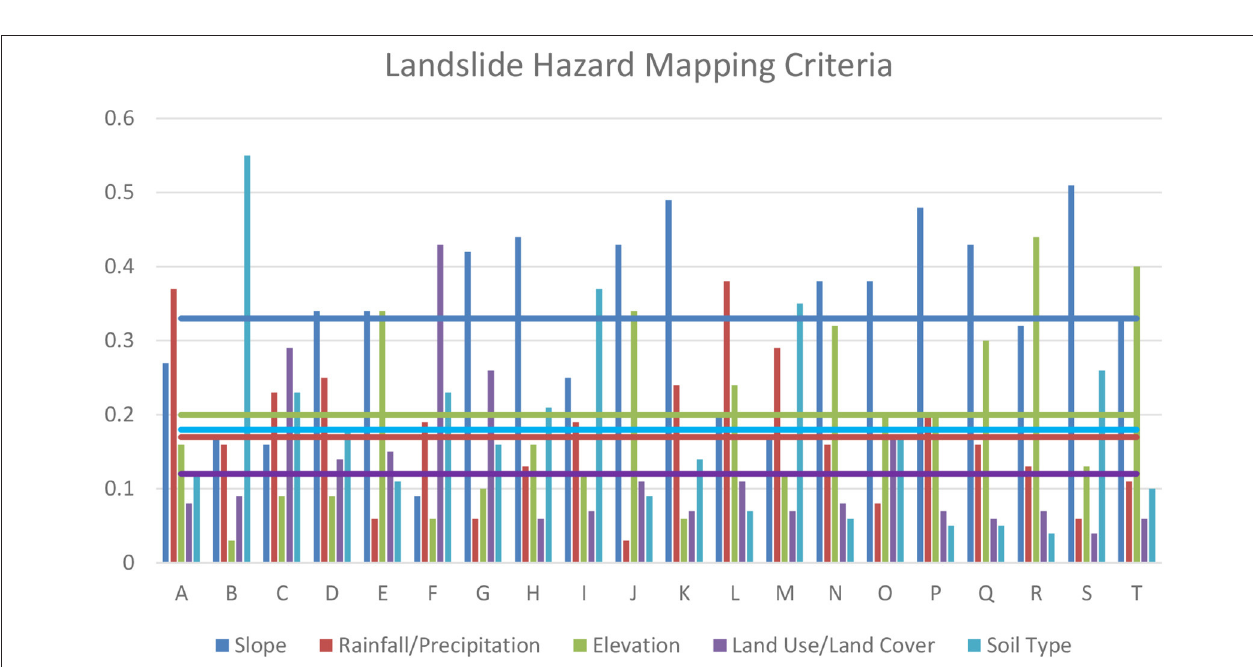
FIGURE 3 | Weights of the criteria for flood hazard mapping using AHP showing the mean values in horizontal lines.